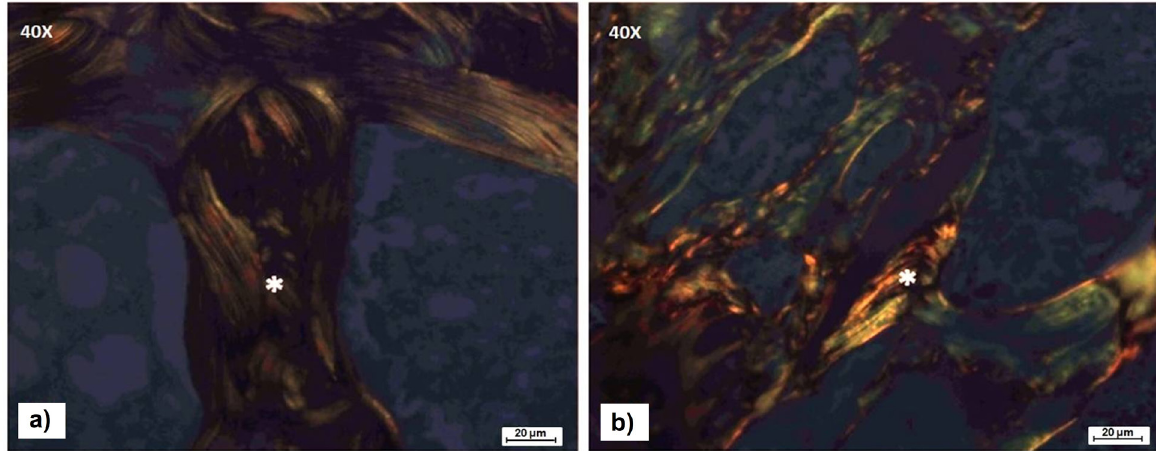
Figure 4. Collagen images from the neck of the femurs analyzed under polarized light microscopy. Bone trabeculae*. In a) total collagen percentage in the control group; in b) total collagen percentage in the ethanol group. The collagen fibers appear in red, orange, and green color (picro sirius red, original magnification 400